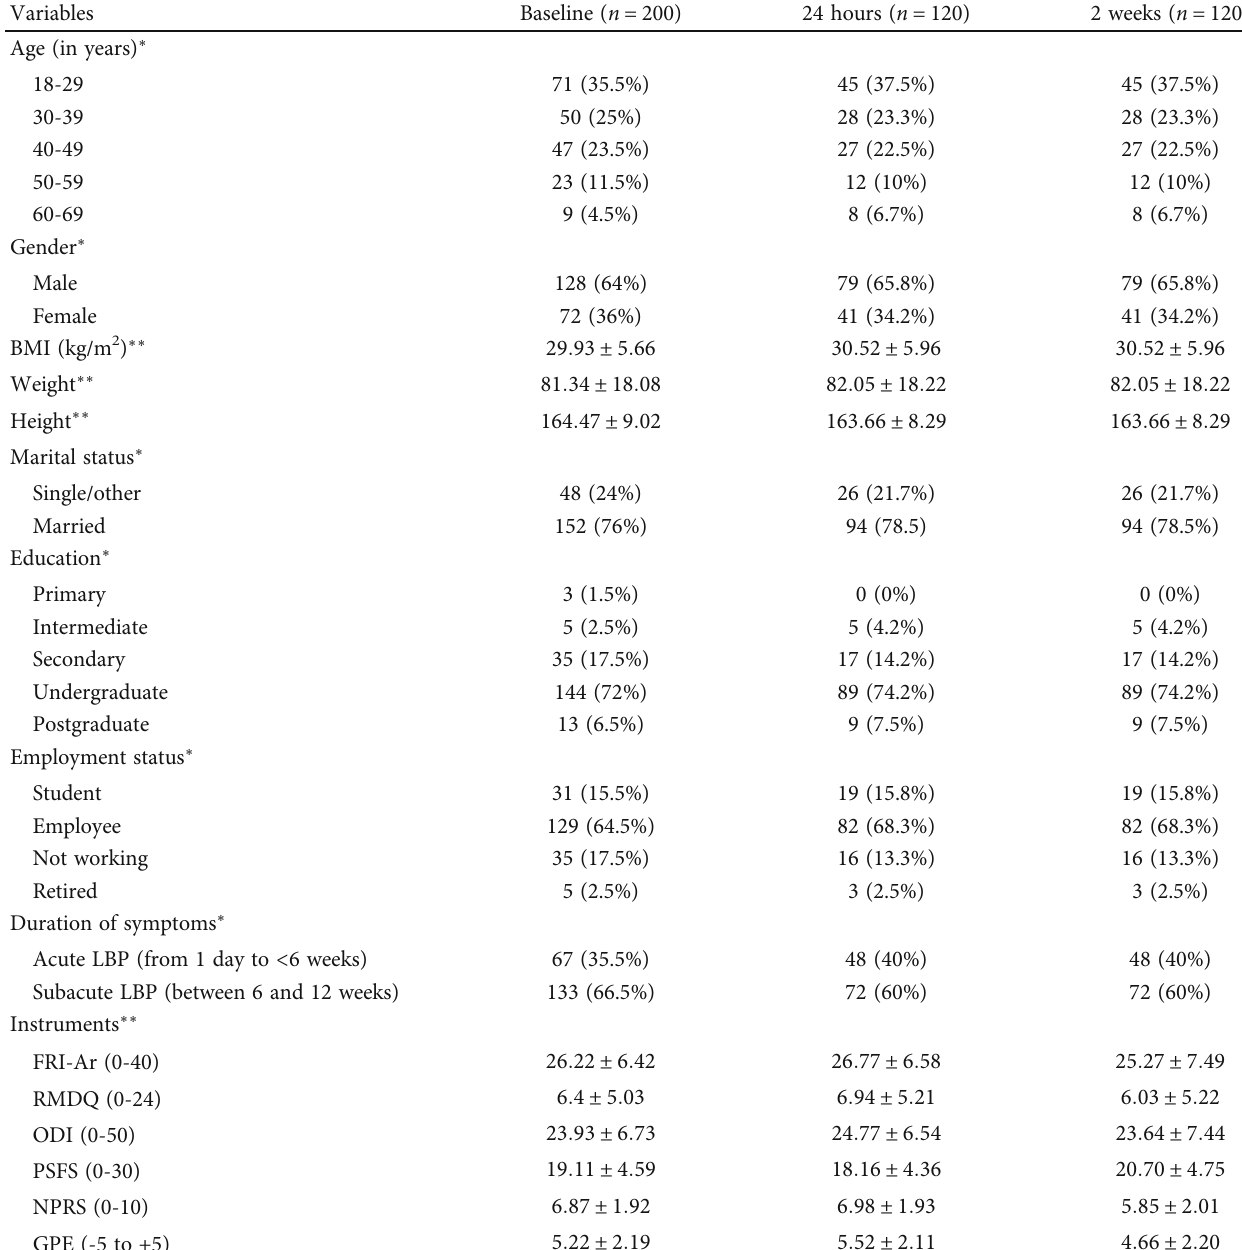
Table 2: Participant ’ s characteristics at baseline and